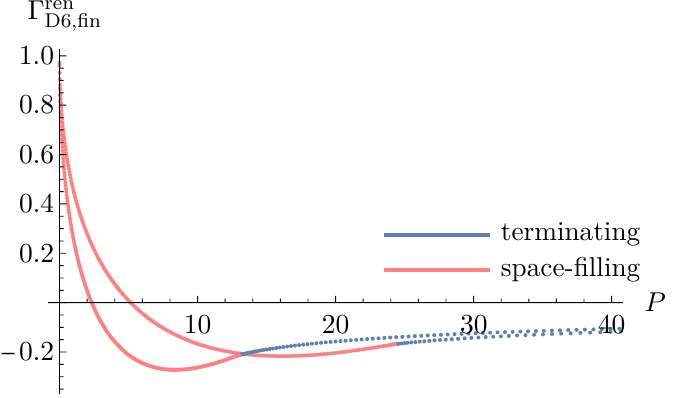
Figure 7. Quantum effective potential with IR divergences subtracted (6.35) (not the F -function) in two schemes b 3 = 1 , 2 where the vev is invertible. Because Γ ren is F ( P )